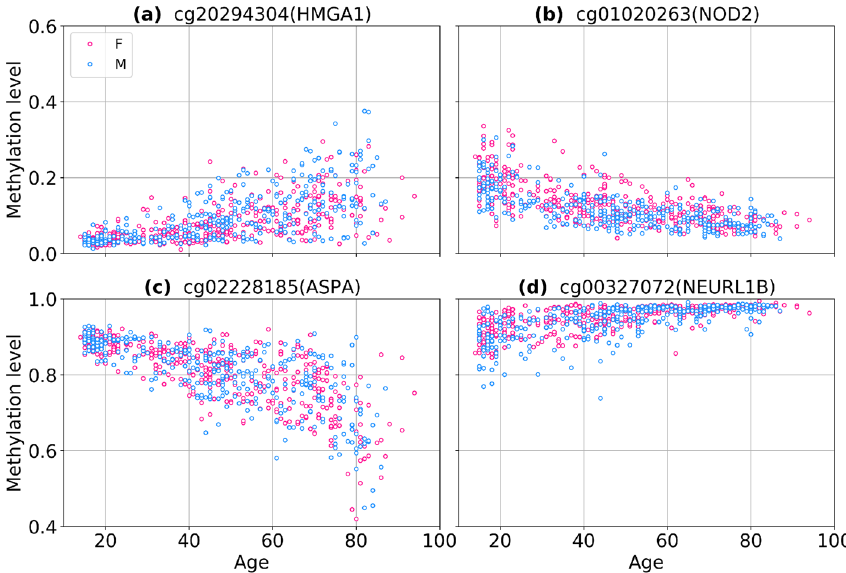
Figure 6. Examples of CpG probes having different quality types of methylation and variability changes in GSE87571 dataset: methylation and variability increase ( a ), methylation and variability decrease ( b ), methylation decreases and variability increases ( c ), methylation increases and variability decreases ( d ).